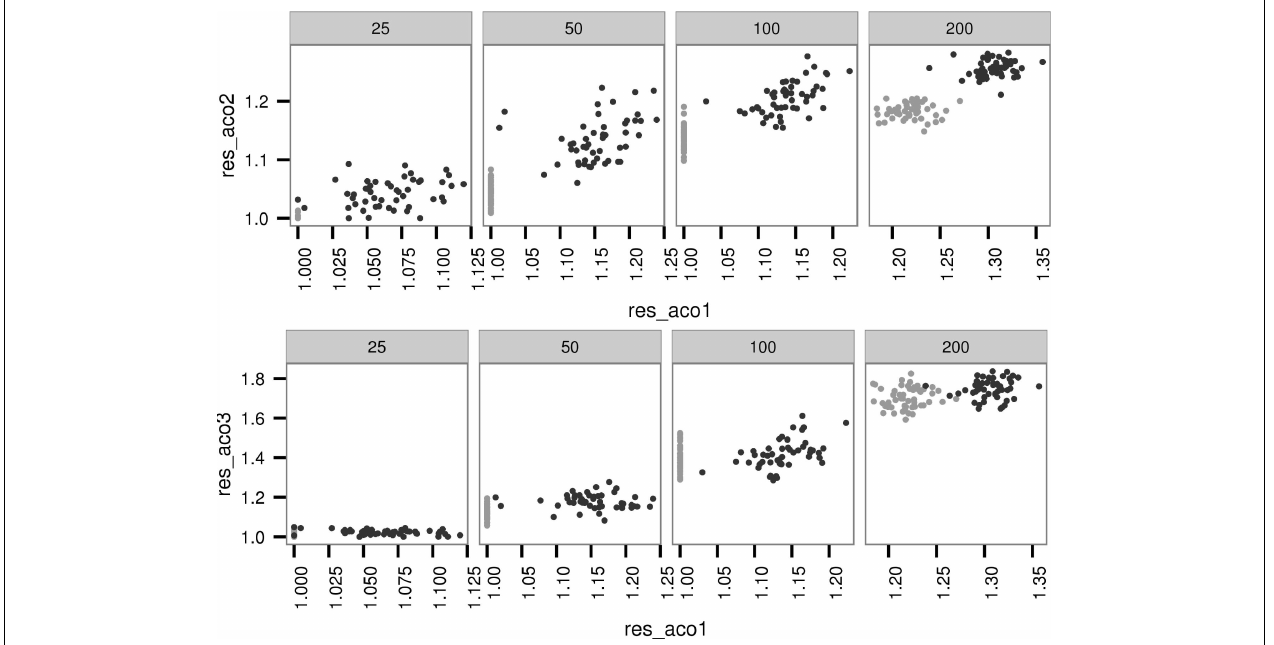
FIGURE 6 | Performance of the second ( res _ aco 2) parameter setting (top) and the third ( res _ aco 3) parameter setting (bottom) on the easy (gray) and hard (black) instances of the first ( res _ aco 1) parameter setting .